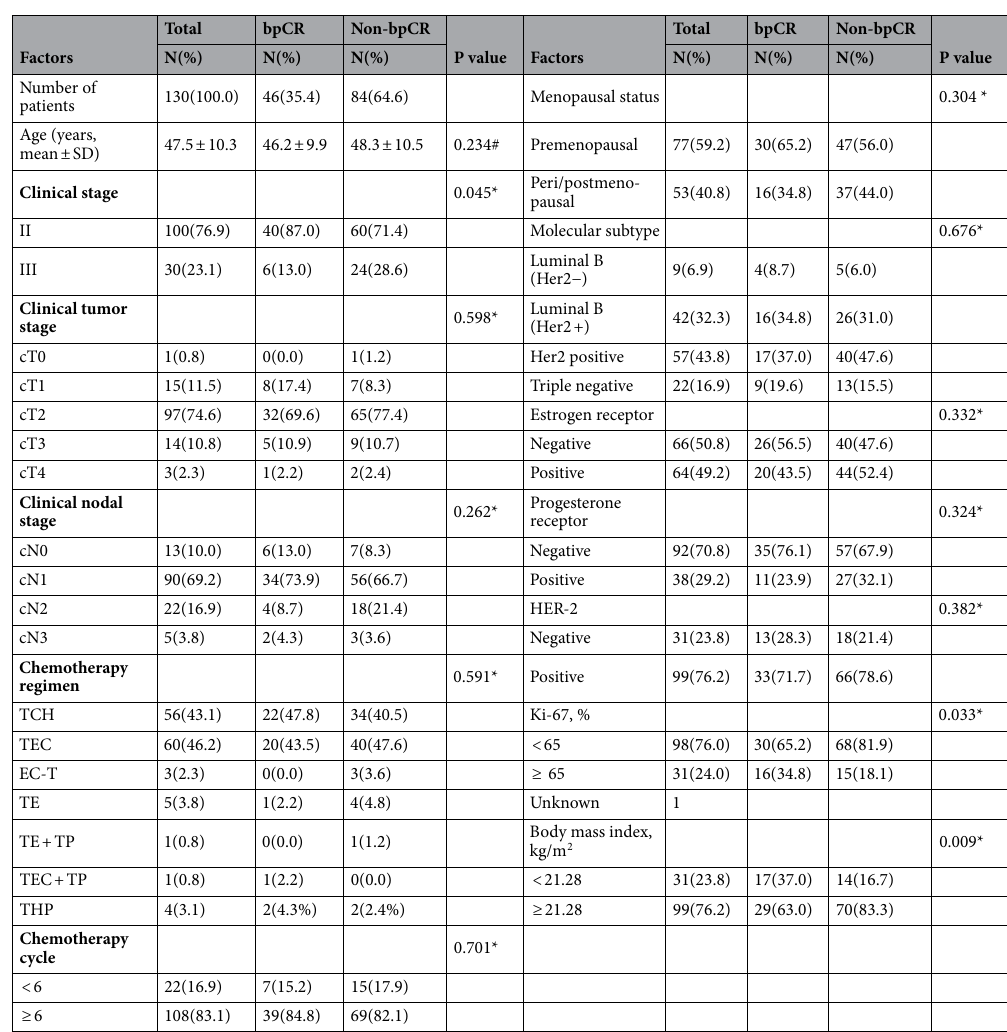
Table 1. Clinical characteristics of 130 breast cancer patients and their association with bpCR rate after NAC. NAC neoadjuvant chemotherapy, bpCR breast pathological complete response, TCH